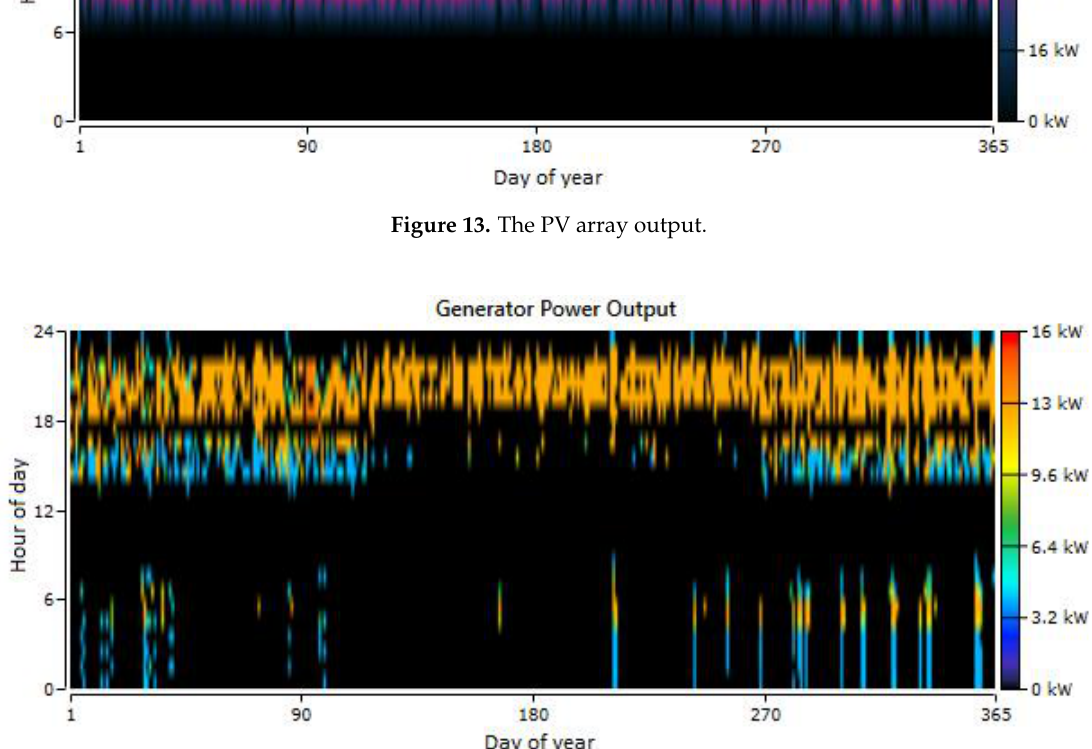
Figure 14. Biogas generator output.